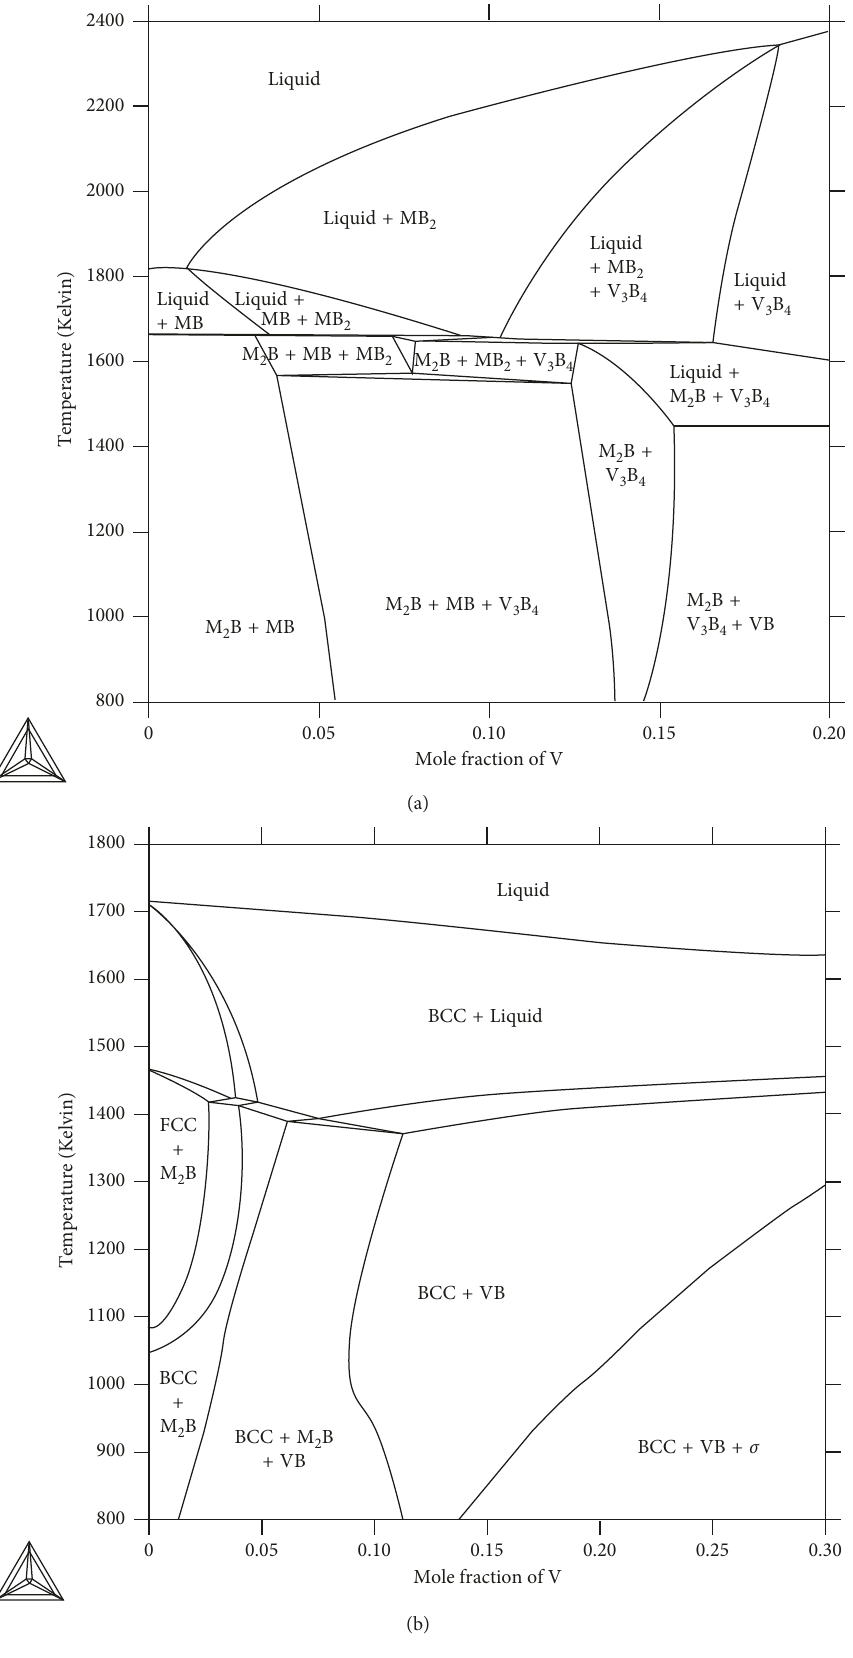
Figure 4: Isopleth of the phase diagram: (a) 40B-Fe-5Mn-V and (b)